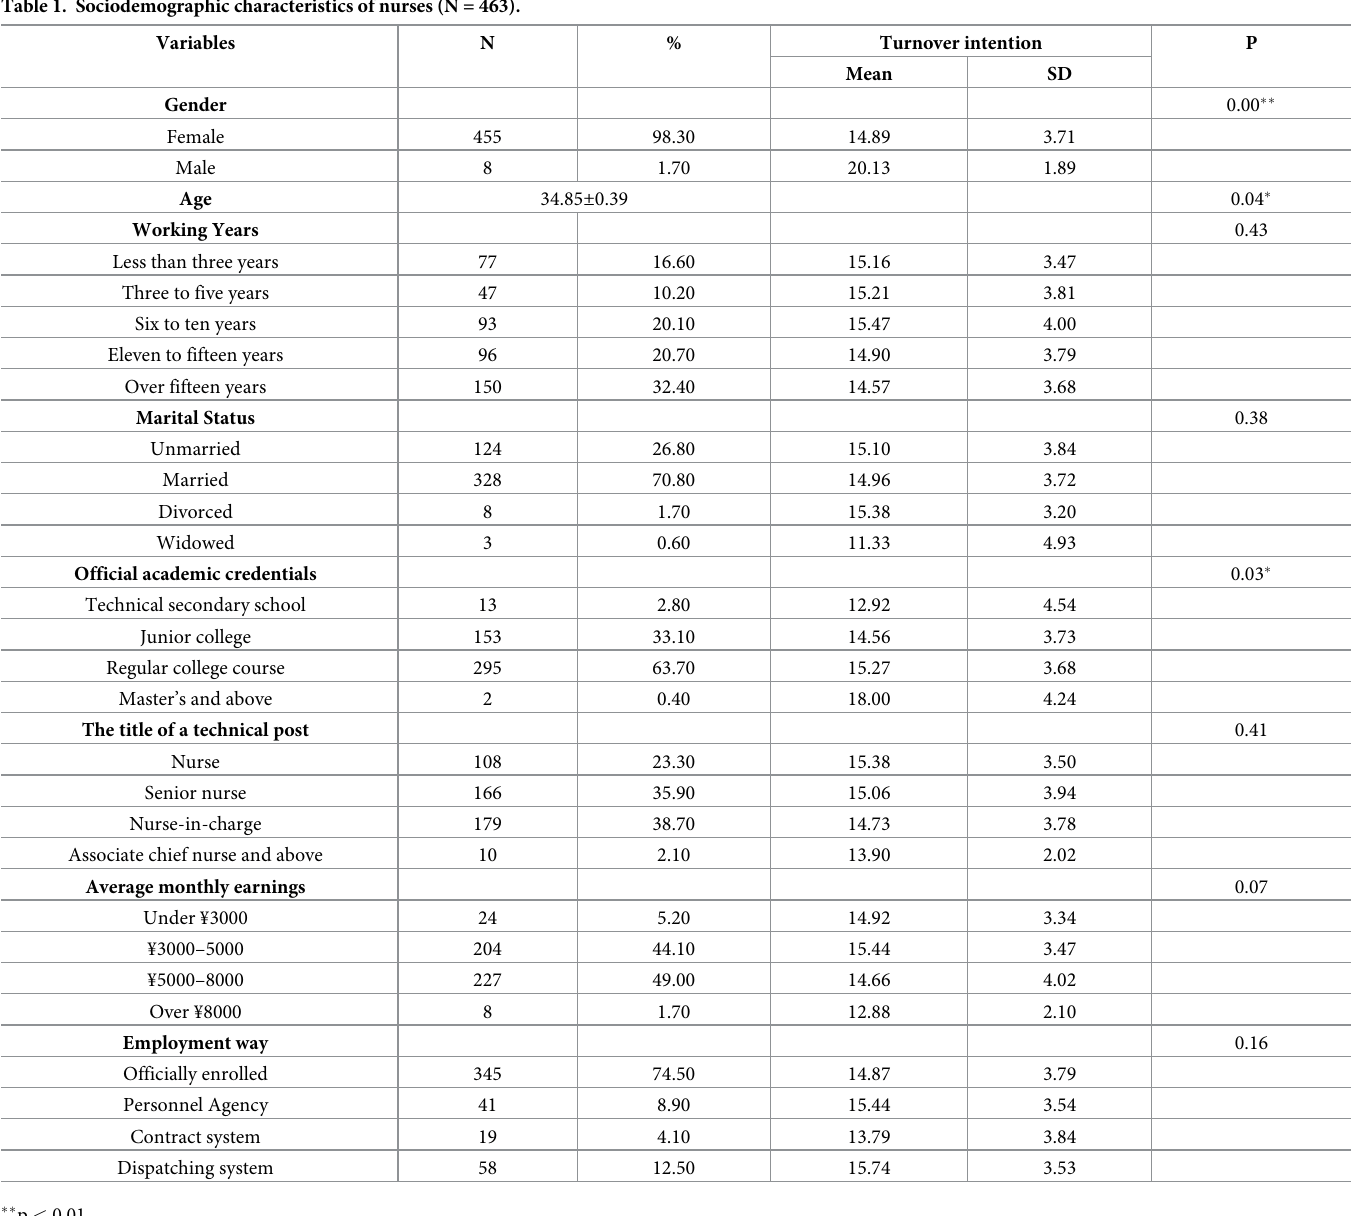
Table 1. Sociodemographic characteristics of nurses (N =